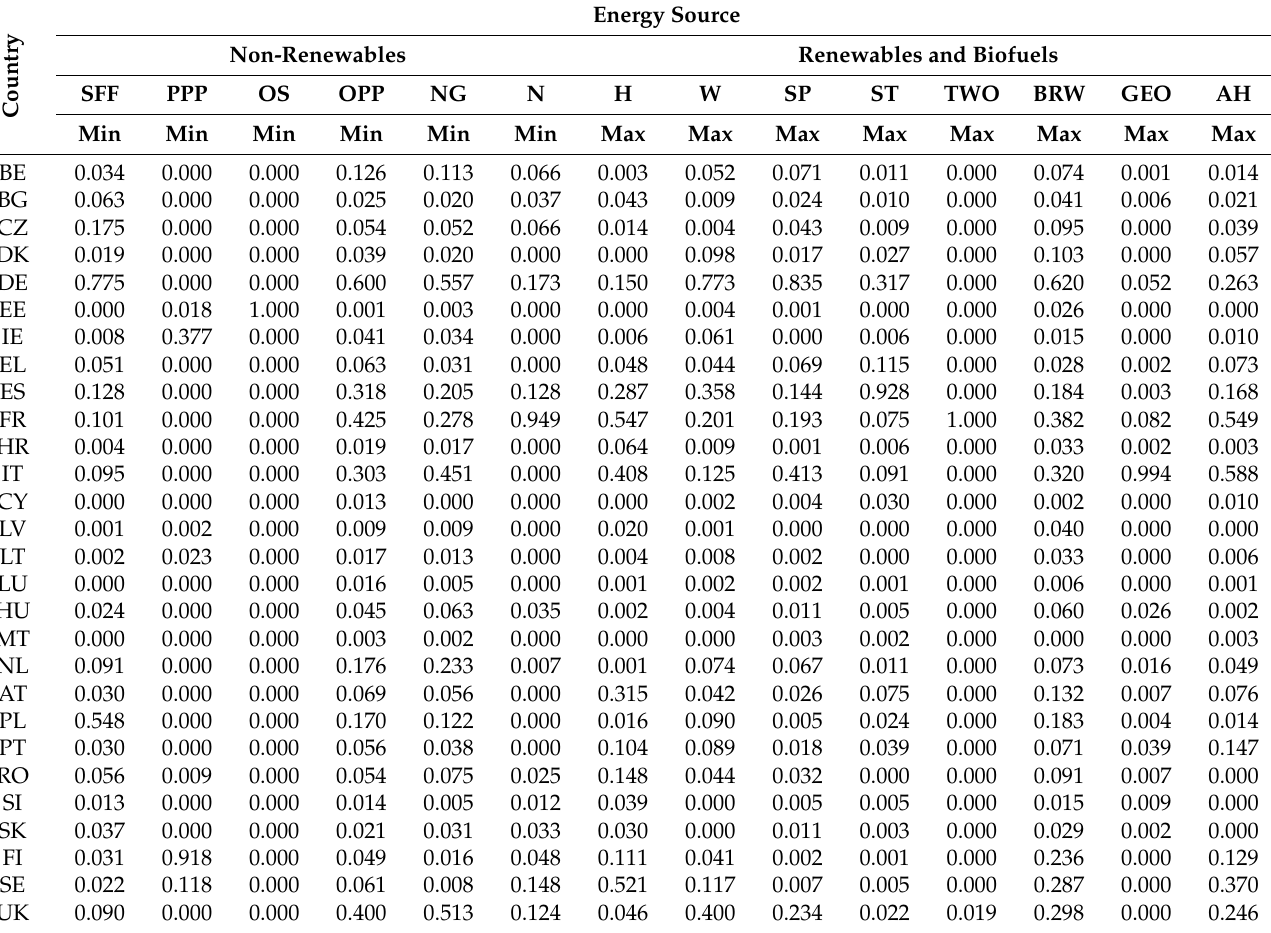
Table 6. Energy consumption in EU countries in 2018—normalization data.